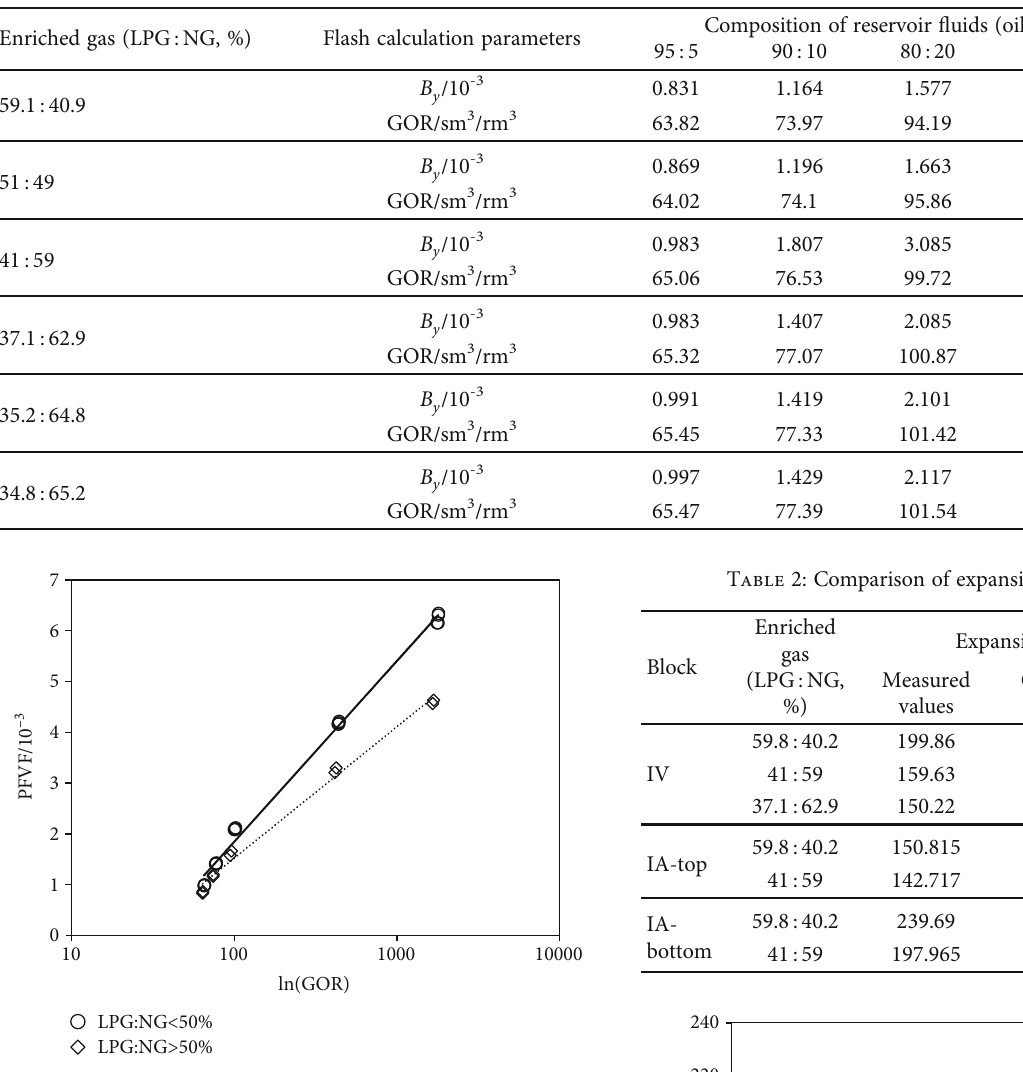
Figure 2: Relationships between PFVF and GOR. The dashed line indicates LPG : NG > 50 % , and the solid line is LPG : NG < 50 % .